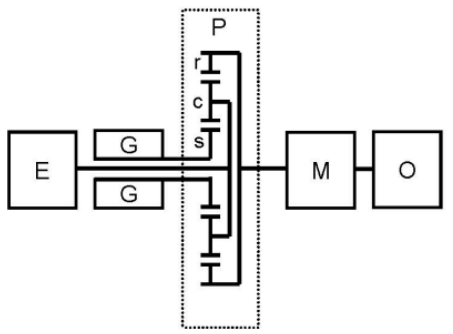
Figure 4. Schematic powertrain architecture of Toyota Hybrid System (THS) in the electric circulation mode.